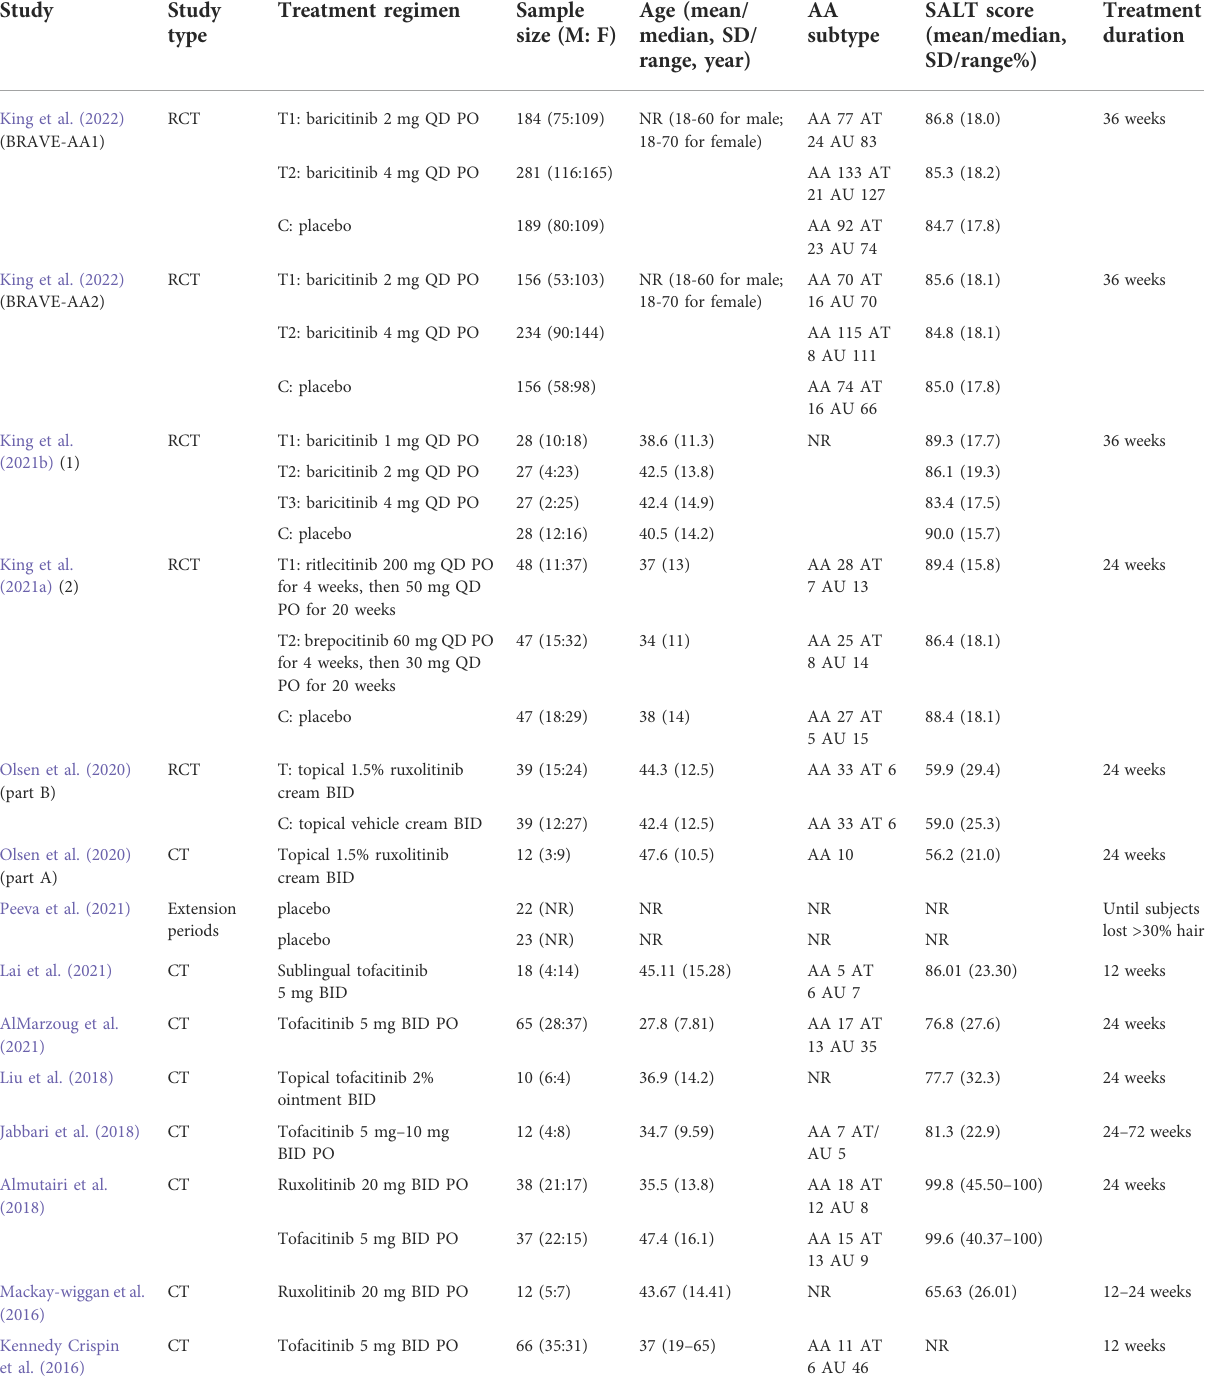
TABLE 1 Characteristics of included